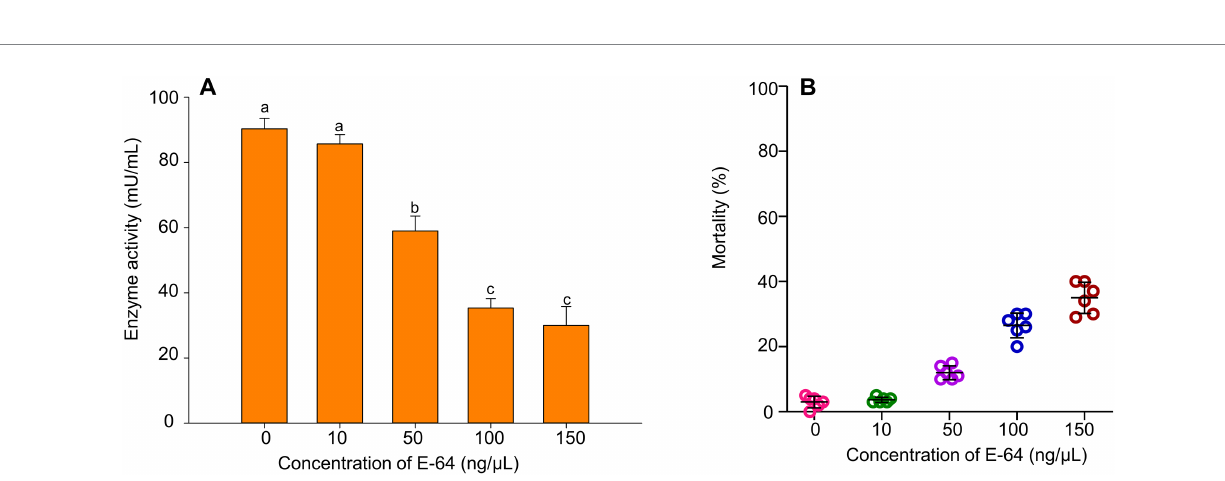
FIGURE 5 The effect of E-64 treatment on B. tabaci MED. (A) The enzyme activities of cathepsin B on B. tabaci MED of different concentrations of E-64 treatment. (B) The mortality effect on B. tabaci MED of different concentrations of E-64 treatment. In (A) , values are denoted as means±SE; means with different letters are significantly different at p <